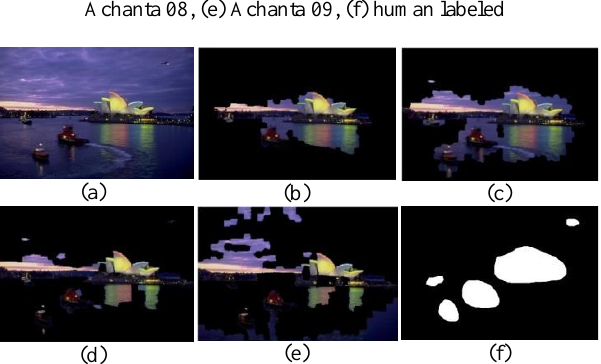
Figure 8. (a) original image, (b) SS&KD, (c) Rare2012, (d)